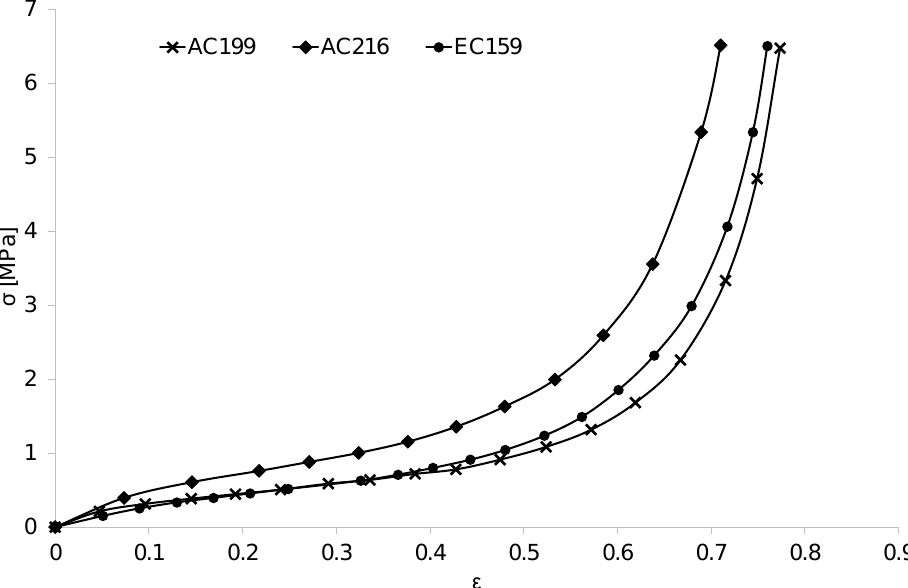
Figure 3. Cork agglomerates and EPS foam engineering stress-strain curves.